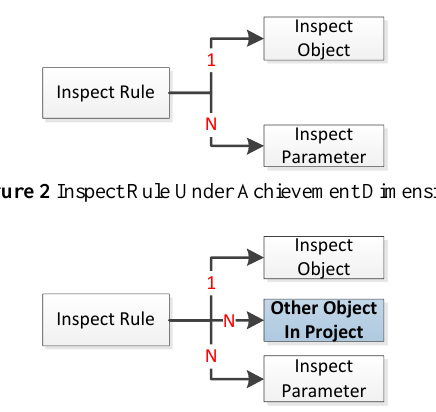
Figure 3 Inspect Rule Under Project Dimension